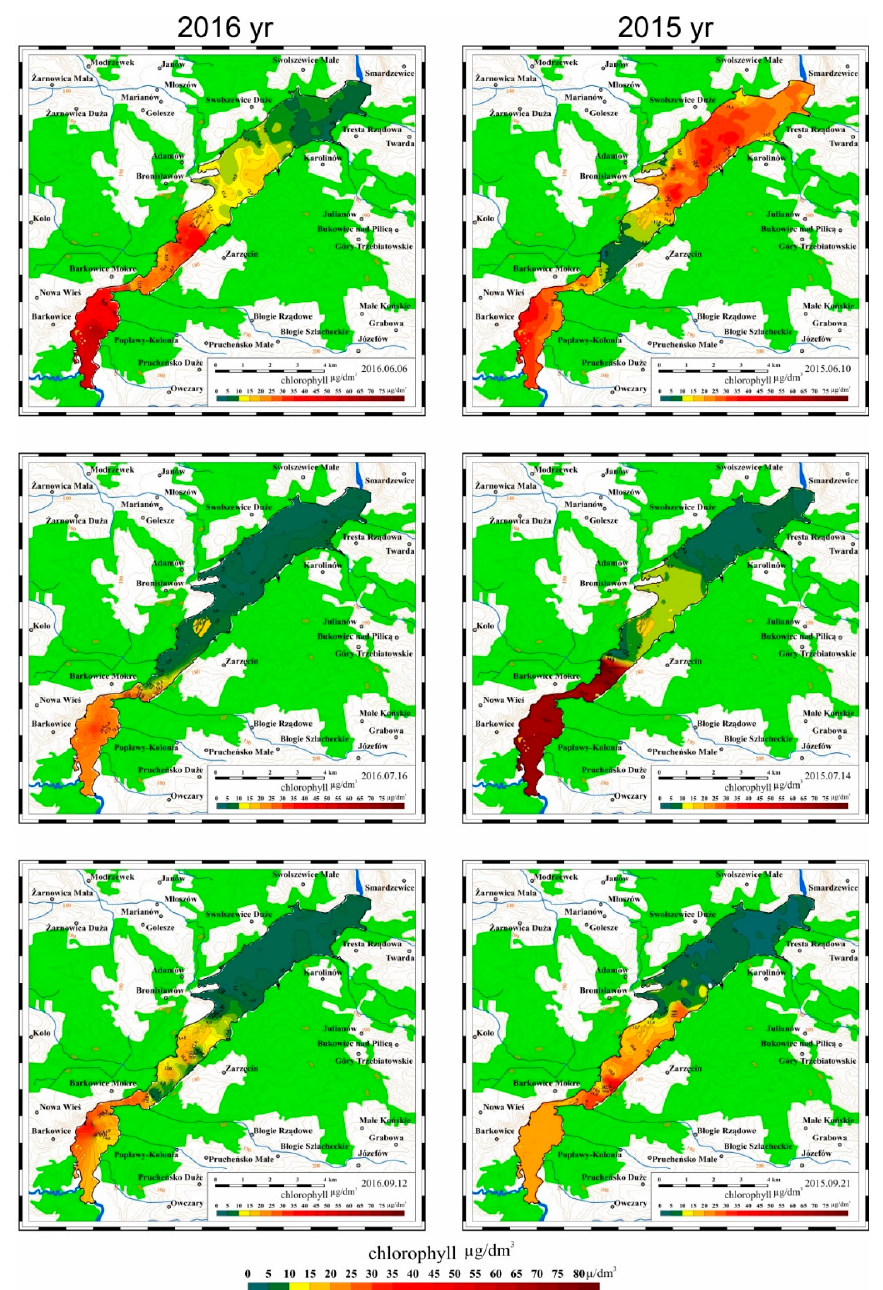
Figure 9. Spatial distribution of chlorophyll concentration in the Sulejow Reservoir between June and September 2015 and